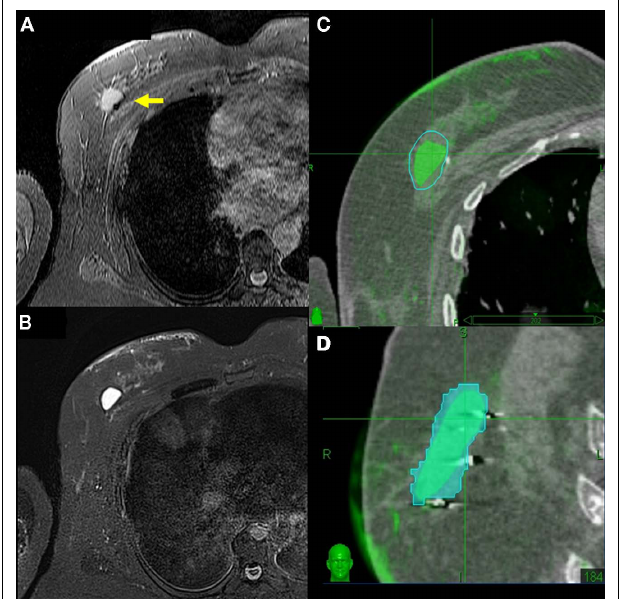
FIGURE 1 | Example of MRI images and image fusion. (A) T2* gradient-echo MRI image, yellow arrow denotes the fiducial markers. (B) STIR MRI image showing resection cavity. (C,D) Axial and sagittal fused